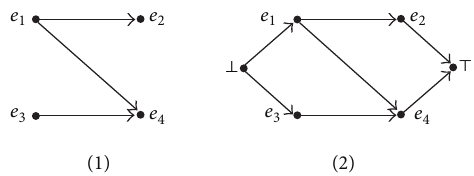
Figure 1: Partial order trace and its directed graph